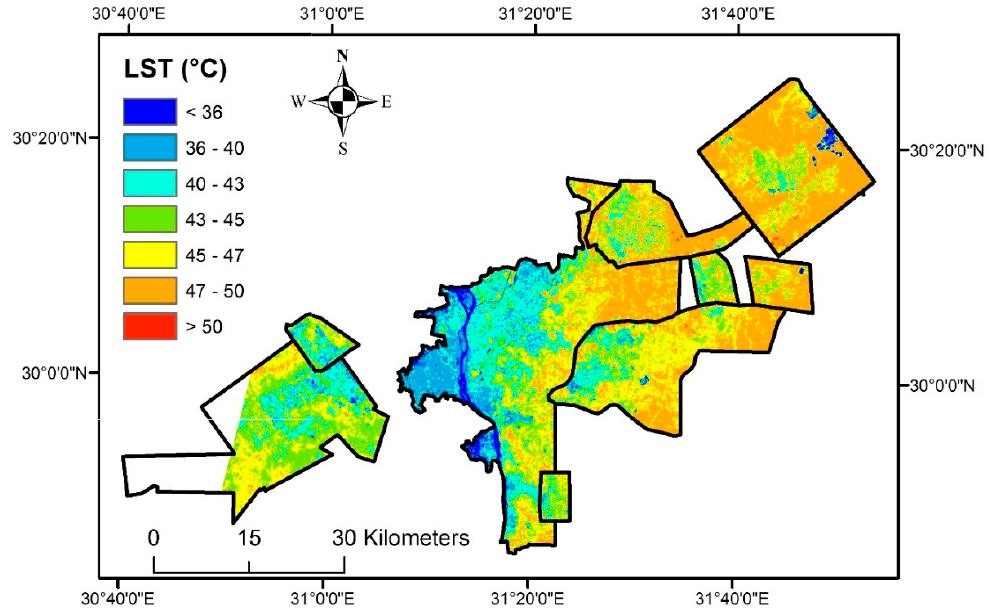
Figure 3. LST (Land Surface Temperature) map of Cairo and its new towns, extracted from Landsat image (8 August 2012, 8:18 a.m. UTC).